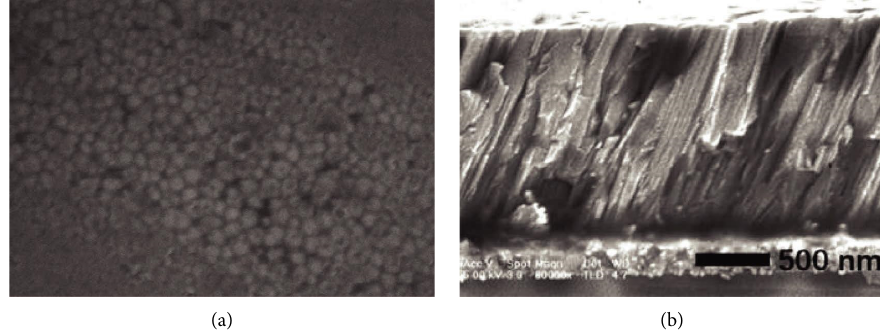
Figure 4: Te Scanning electron microscopy (SEM) pictures of the AlN thin flm, (a) is for AlN surface morphology, (b) is for cross section view.